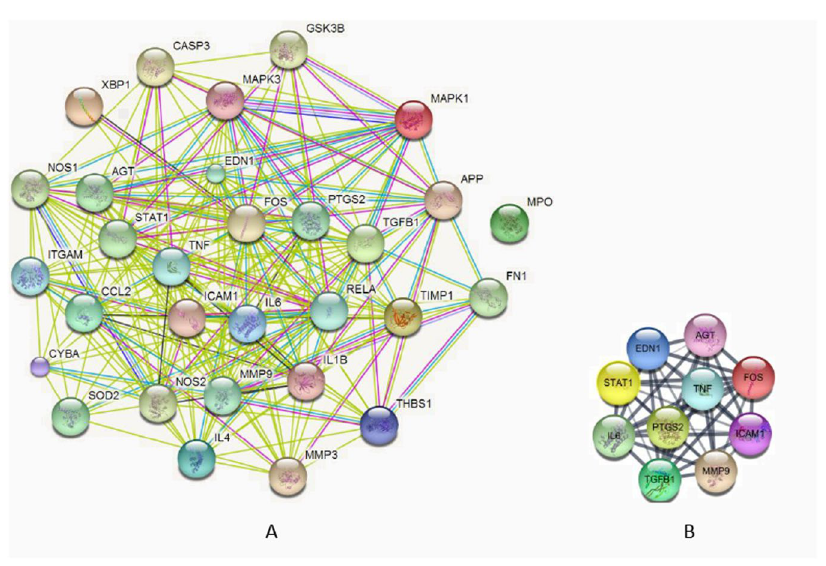
Figure 1. Protein–protein (PPI) networks. ( A ) The GAS30 network and ( B ) and GAS10 sub-network ( A ) presented in Table 2. Smaller nodes indicate the proteins whose three-dimensional structures were undetermined;larger nodes indicate the determined or predicted proteins. Colors of lines (edges) represent different interaction